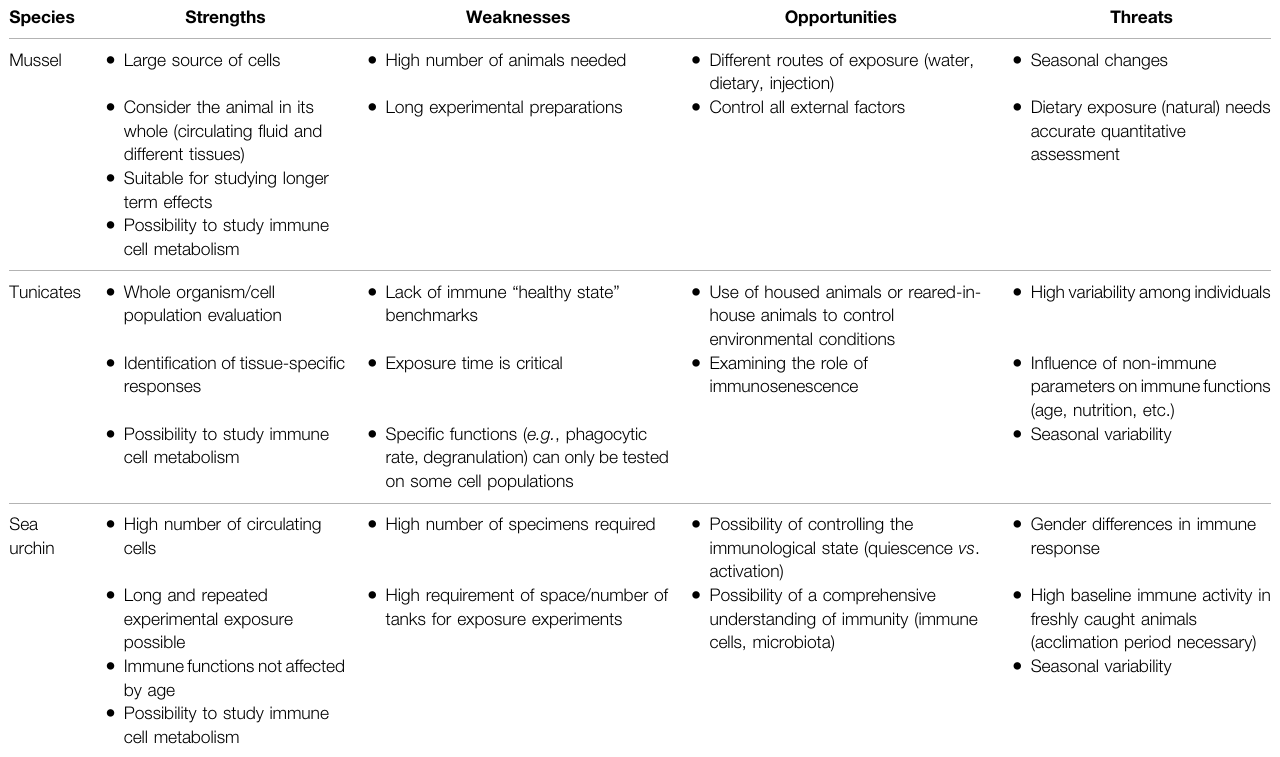
TABLE 2 | SWOT analysis of in vivo animal models for immunotoxicity assessment. Species